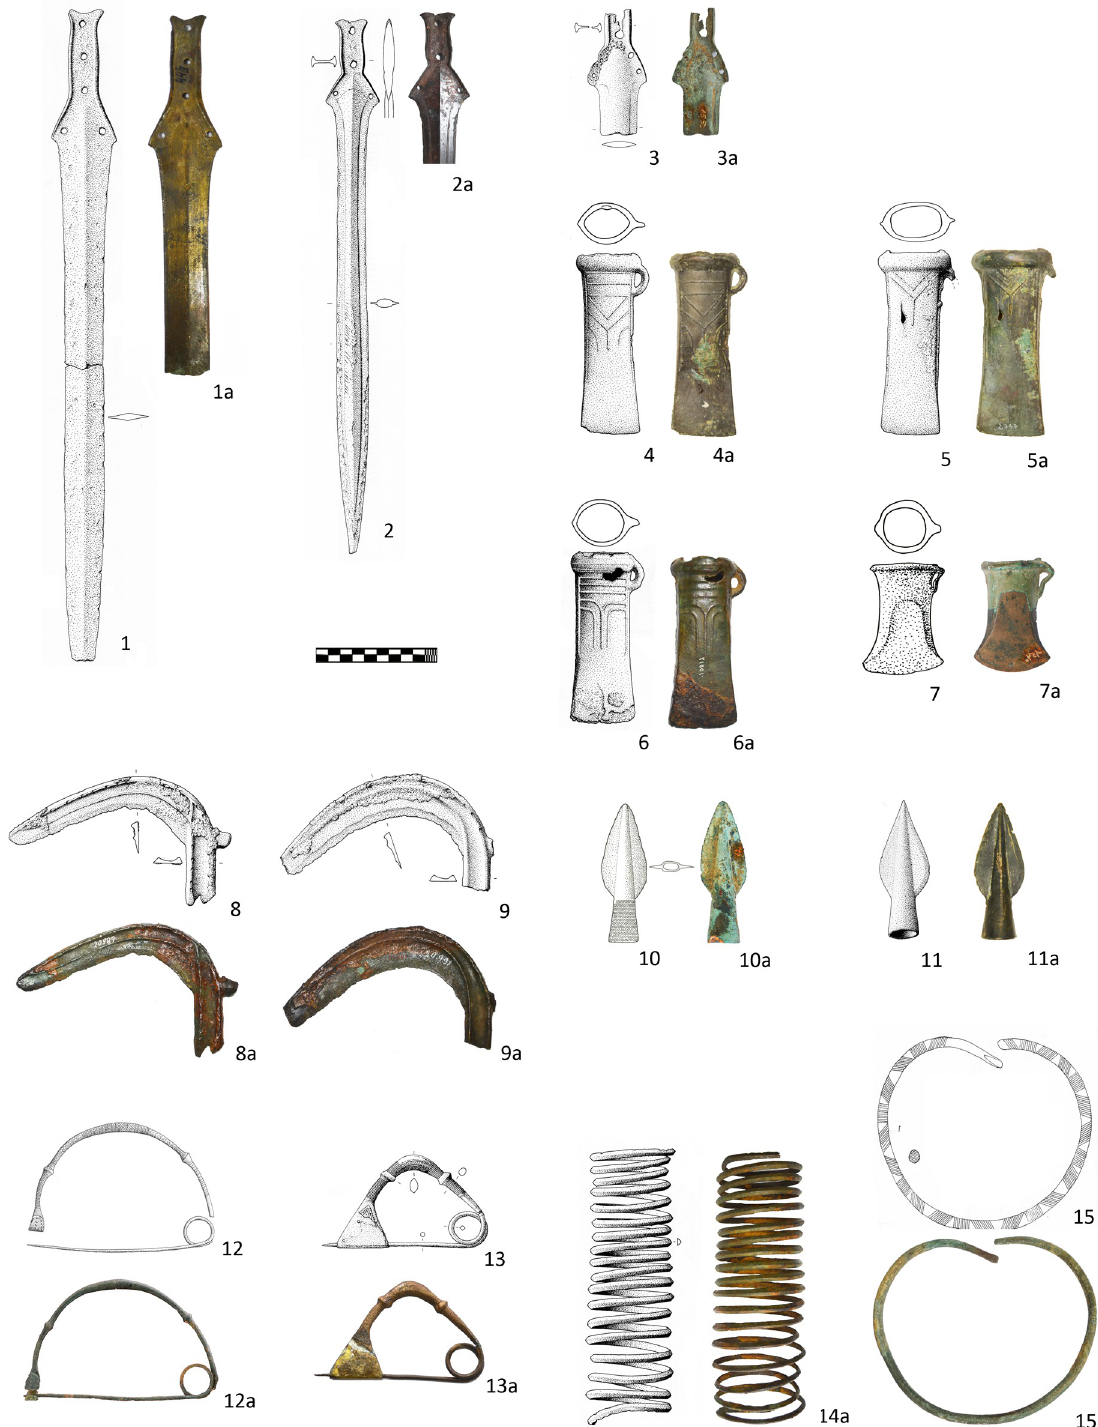
Fig 3. Group 2 of sampled metal objects (Ha A2–Ha B1). 1. Sivec; 2: Vojskova; 3. 7. 15: Leskovo; 4–5. 11: Brezovo Polje; 6.8–9.13–14: Drenov Do; 10. Vojilovo; 12: Demir Kapija (1–3: reprinted from [41] under CC BY license with permission from A. Jockenho¨vel,